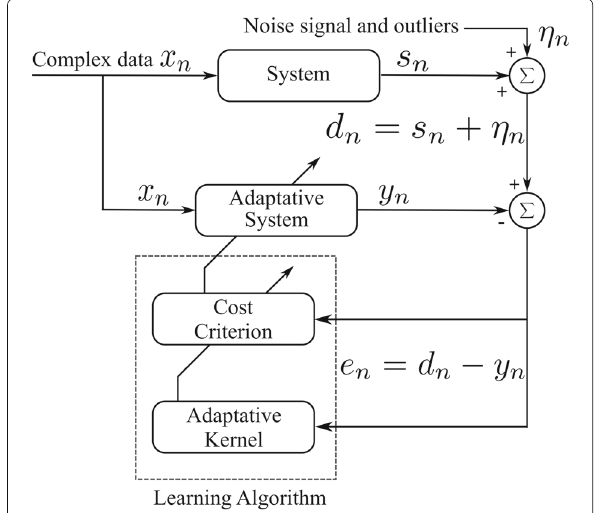
Fig. 1 Block diagram of the system identification problem